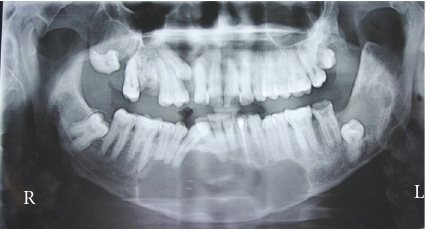
Figure 4: Orthopantomograph shows multiple radiolucencies associated with mandibular anterior region, maxillary right and left as well as mandibular left impacted third molar